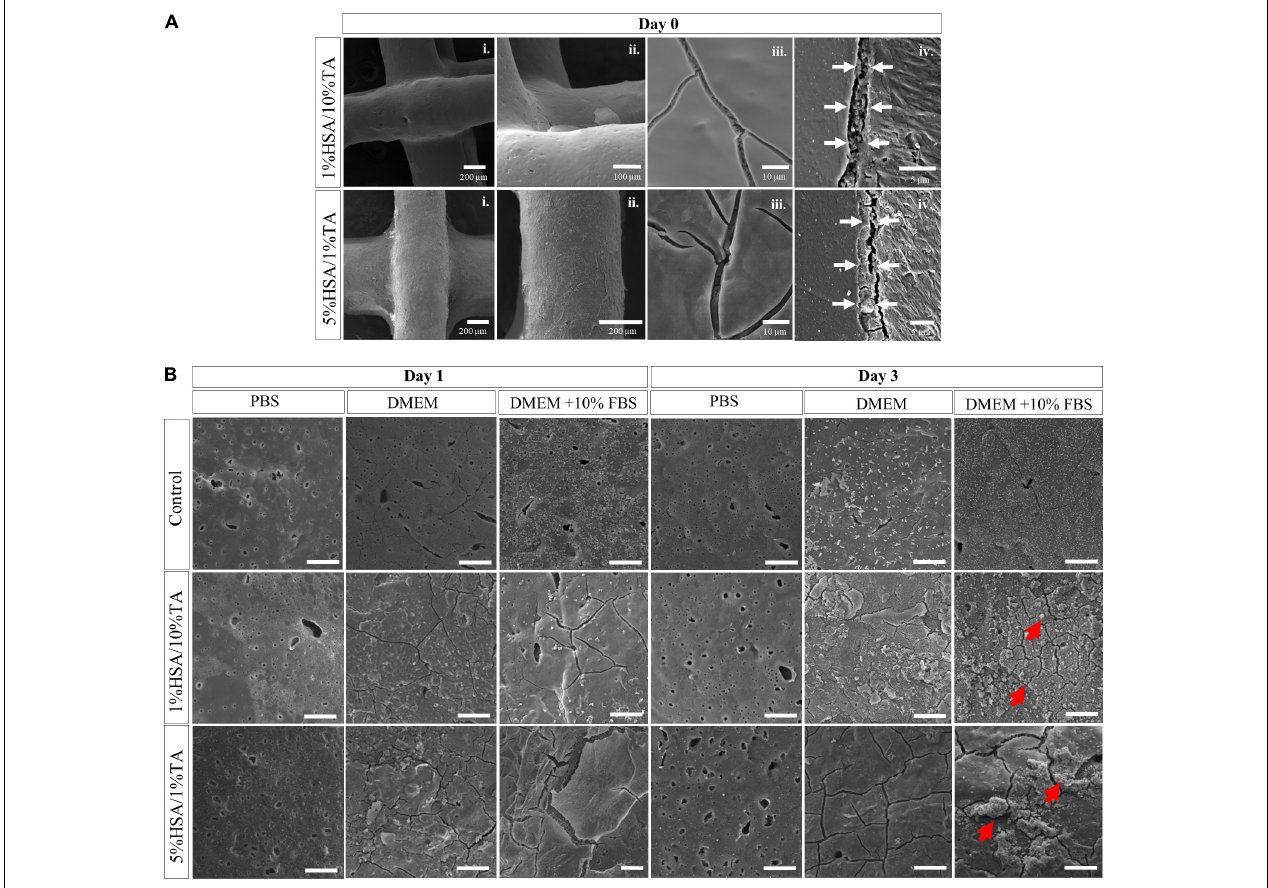
FIGURE 2 | Scanning electron microscopy images showing (A) the surface of HSA/TA coated scaffolds after fabrication, from lower (i) to higher (iii) magnifications, as well as (iv) resin-embedded cross sections evidencing distinctive coating thicknesses. (B) SEM images of uncoated and coated scaffolds after incubation in PBS, DMEM and DMEM + 10% FBS at 37 ◦ C, for 3 days. Red arrows indicate adhered agglomerates on the coated surfaces. Scale bars: 20 µ m.